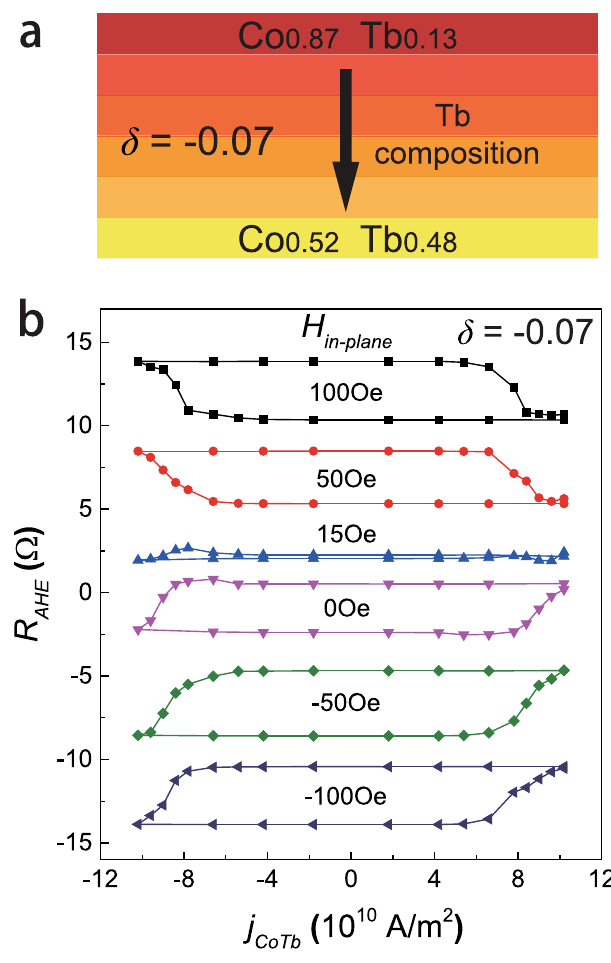
Fig. 4 Comparison experiments on a CoTb sample with inverse gradient. a Structure of the sample with δ = − 0.07. b SOT switching curves of the sample ( δ = − 0.07) under different in-plane magnetic fi elds (including zero- fi eld). This sample shows opposite switching polarity as well as an opposite DMI-induced fi eld compared to the sample in Fig. 3b ( δ = 0.07), verifying the vertical gradient-induced origin of SOT and DMI in our